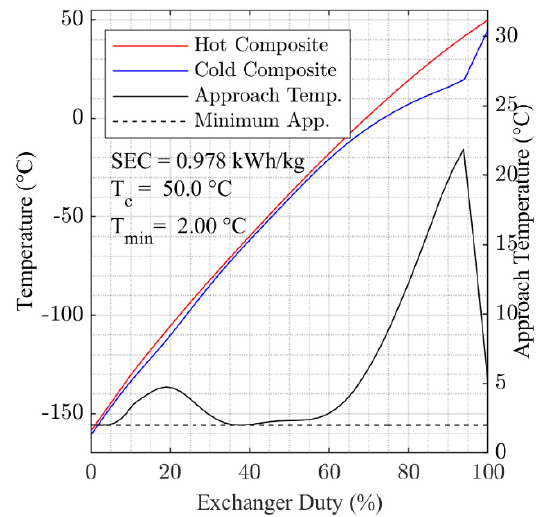
Figure 7. Composite curves in HX-1 and key performance parameters, 50 °C cooling temperature case.